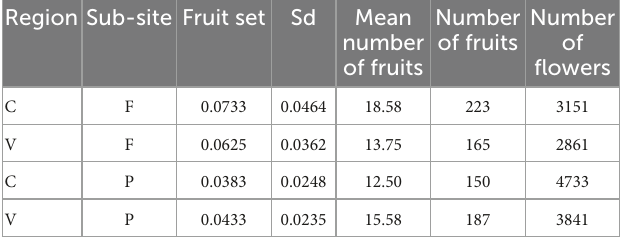
Number Number number of fruits of fruits